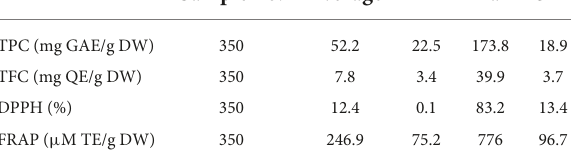
TABLE 1 Summary of the antioxidant-related